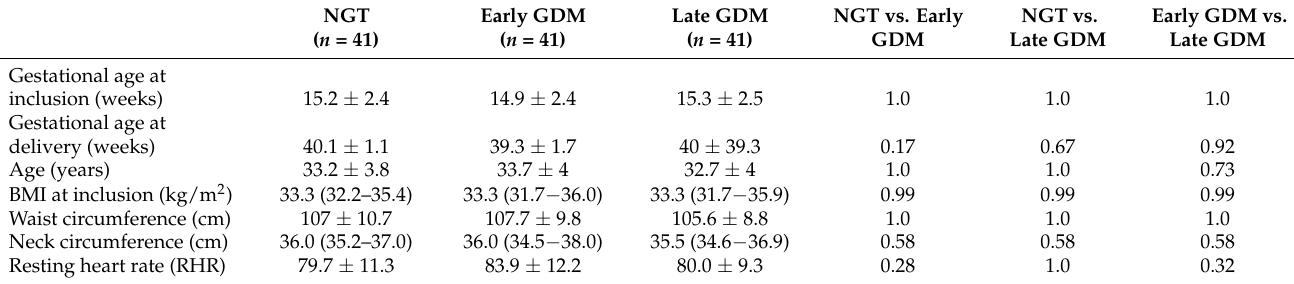
Table 1. Baseline characteristics for anthropometric and clinical parameters of study participants measured prior to 20 gestational